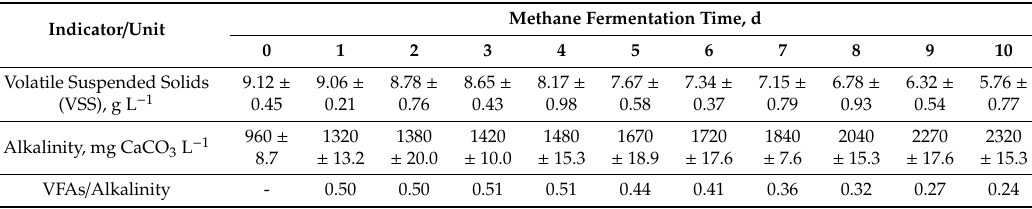
Table 4. Changes of chosen physico-chemical parameters of disintegrated excess sludge with an